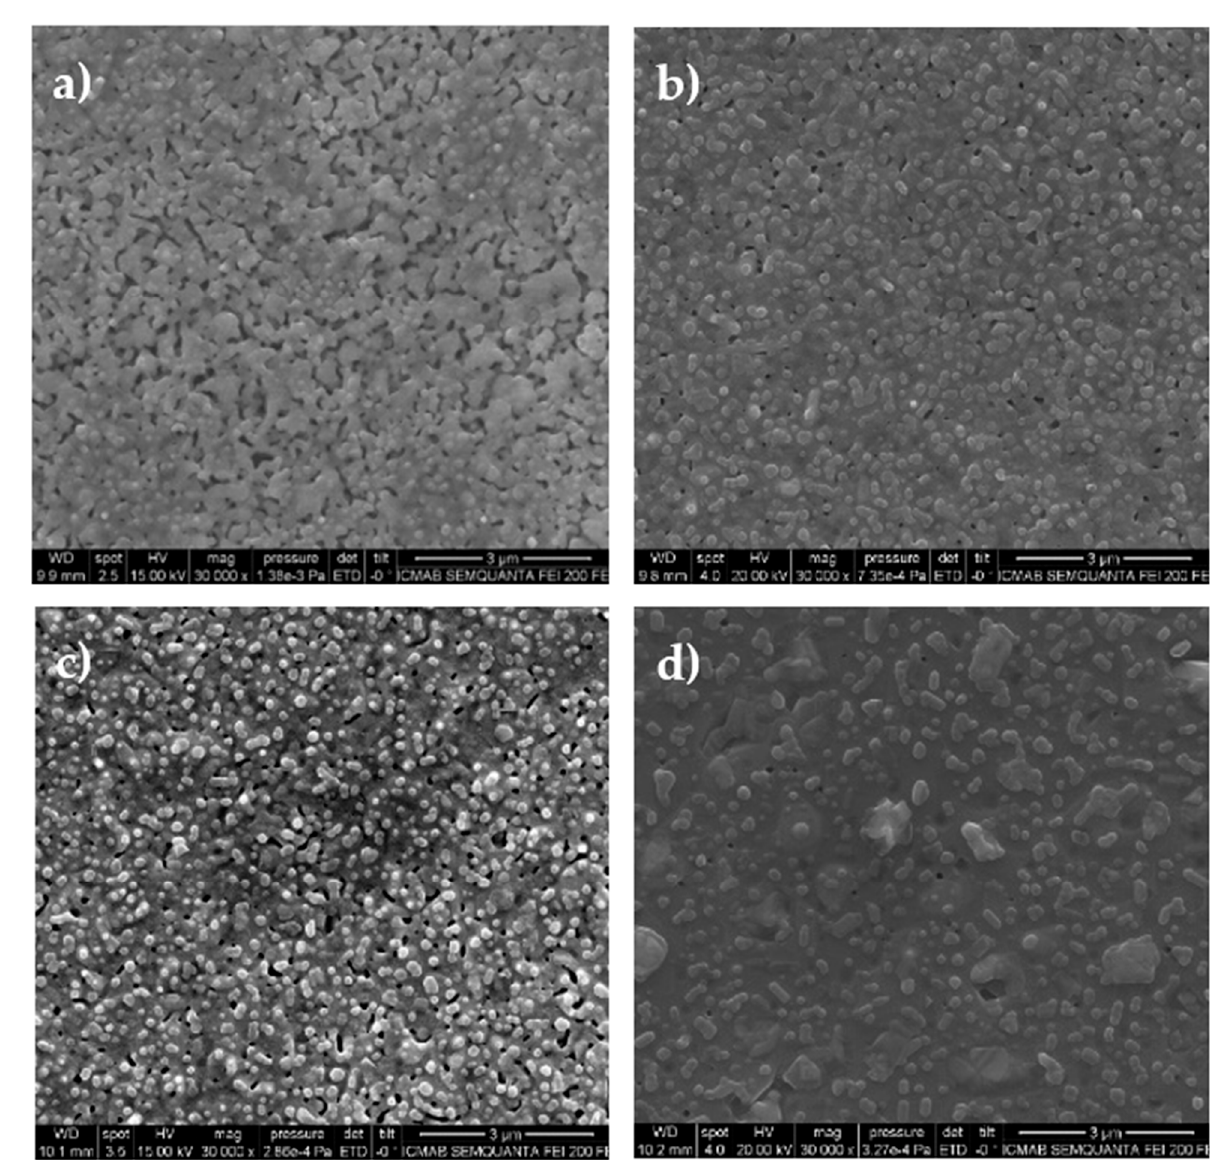
Figure 1. SEM images of different samples grown with the conventional thermal annealing (CTA) method at: ( a ) 730, ( b ) 750, ( c ) 770 and ( d ) 810 °C.